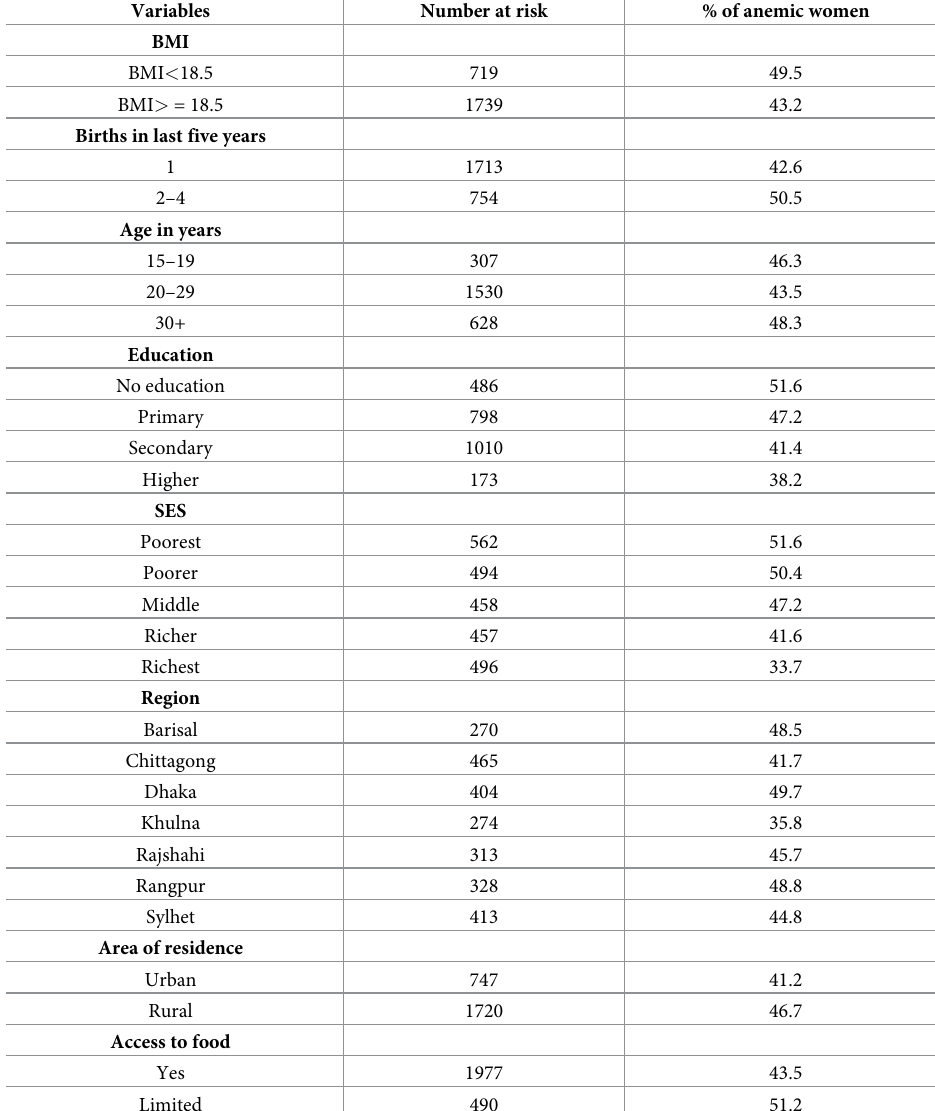
Table 2. Distribution of anemic women by their background